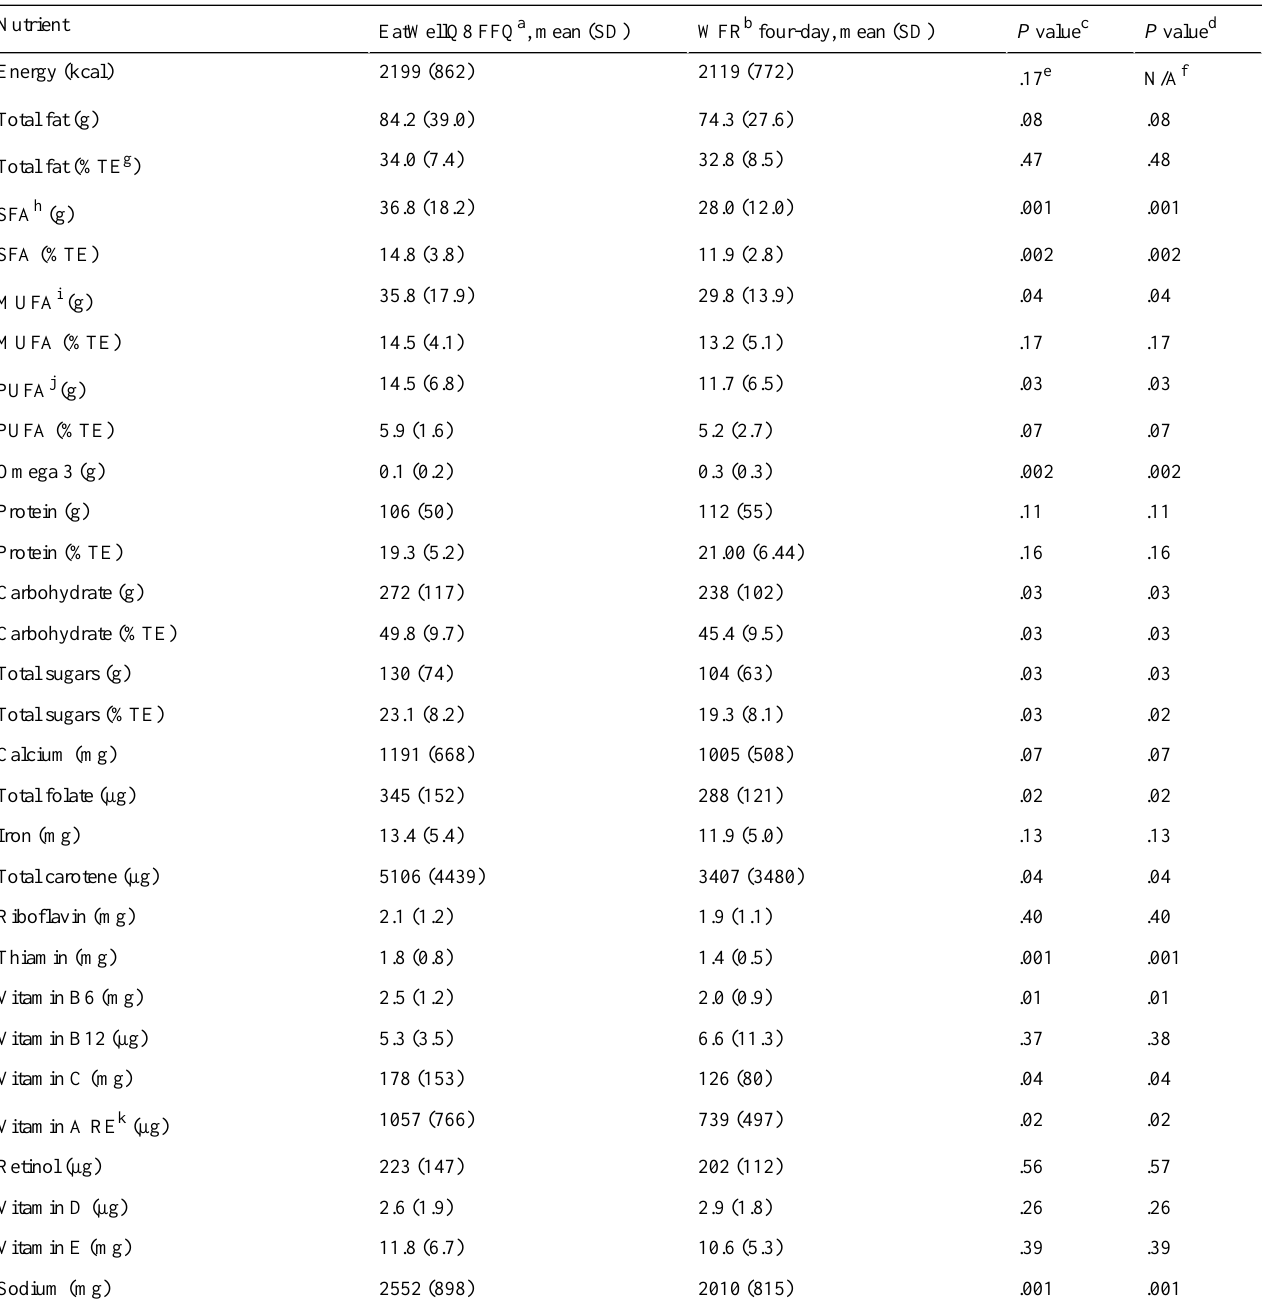
Table 4. Mean daily energy and nutrient intakes estimated by the web-based EatWellQ8 food frequency questionnaire and a four-day weighed food record and general linear model results